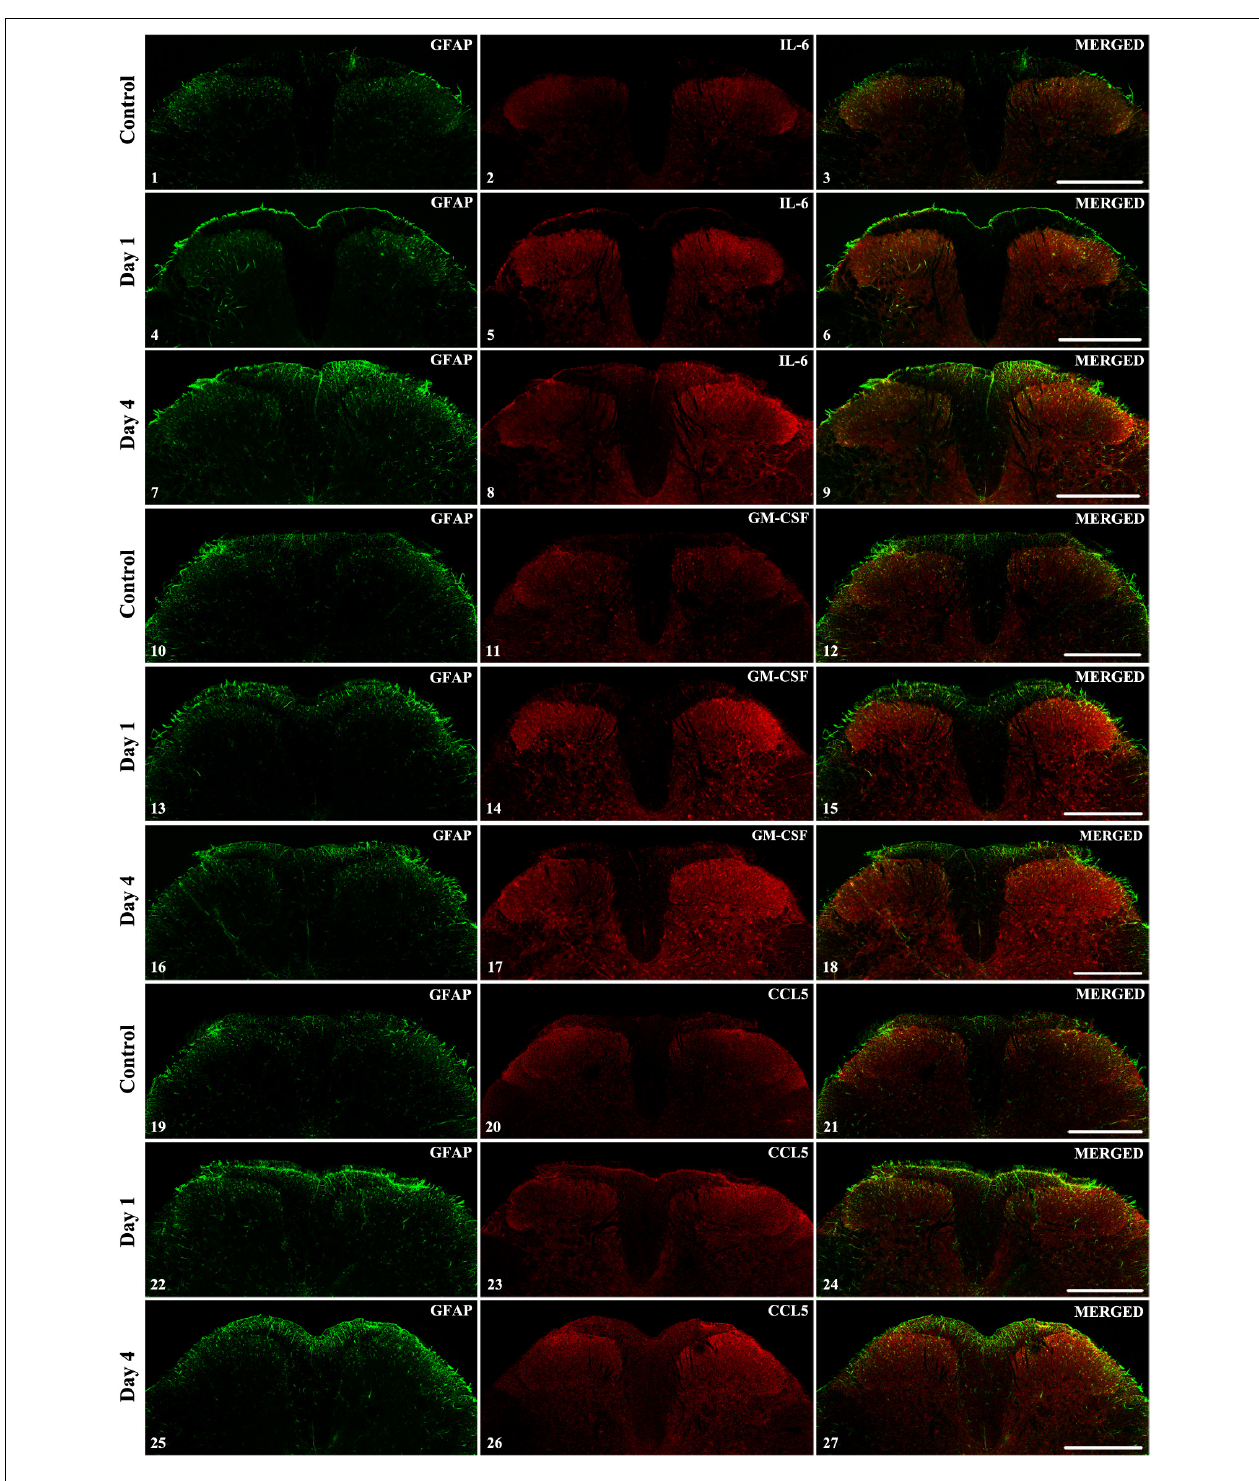
FIGURE 6 | The spinal expression of IL-6, GM-CSF, and CCL5 cytokines during the course of CFA-evoked pain. Representative 1 µ m thick confocal images illustrating the co-localization between immunolabeling for IL-6 (red; 6.2, 6.5, 6.8), GM-CSF (red; 6.11, 6.14, 6.17) CCL5 (red; 6.20, 6.23, 6.26) and the immunoreactivity of astrocytes (GFAP, green; first column of the figures) in the superficial spinal dorsal horn. Mixed colors (yellow) on the superimposed images (last column of the figures) indicate double-labeled structures. For each cytokine the first row of the images are taken from control samples, whereas the second row of images represents the first day after CFA injection and the third row shows the spinal expression of the cytokines on post-injection day 4. Increased labeling of the cytokines was apparent on the ipsi-lateral (right side) of the spinal cords on post-injection day 4 (panels 6.8, 6.17, and 6.26). In each case scale bars: 500 µ m.